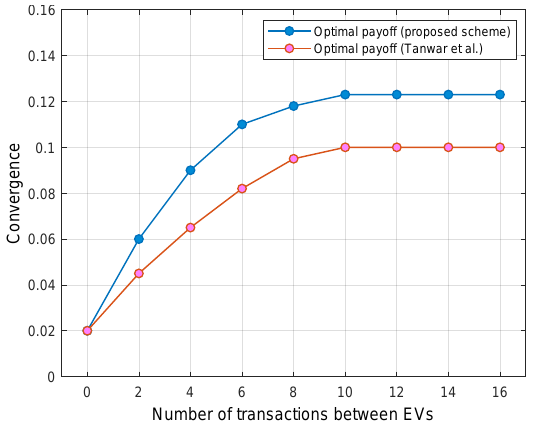
Figure 4. Convergence